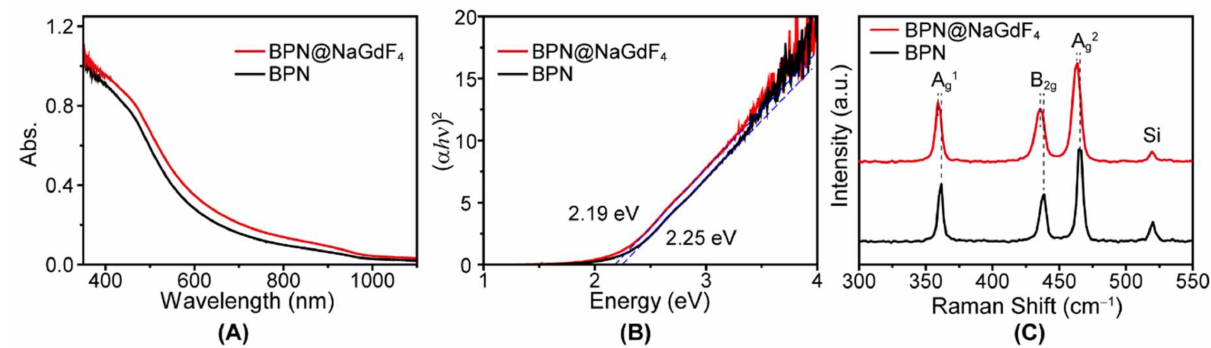
Figure 3. ( A ) The absorption spectra of BPN and BPN@NaGdF 4 ; ( B ) direct Tauc plots used to determine the optical bandgap. α is the absorbance and h ν is the photon energy of the incident light; and ( C ) Raman spectra of BPN and BPN@NaGdF 4